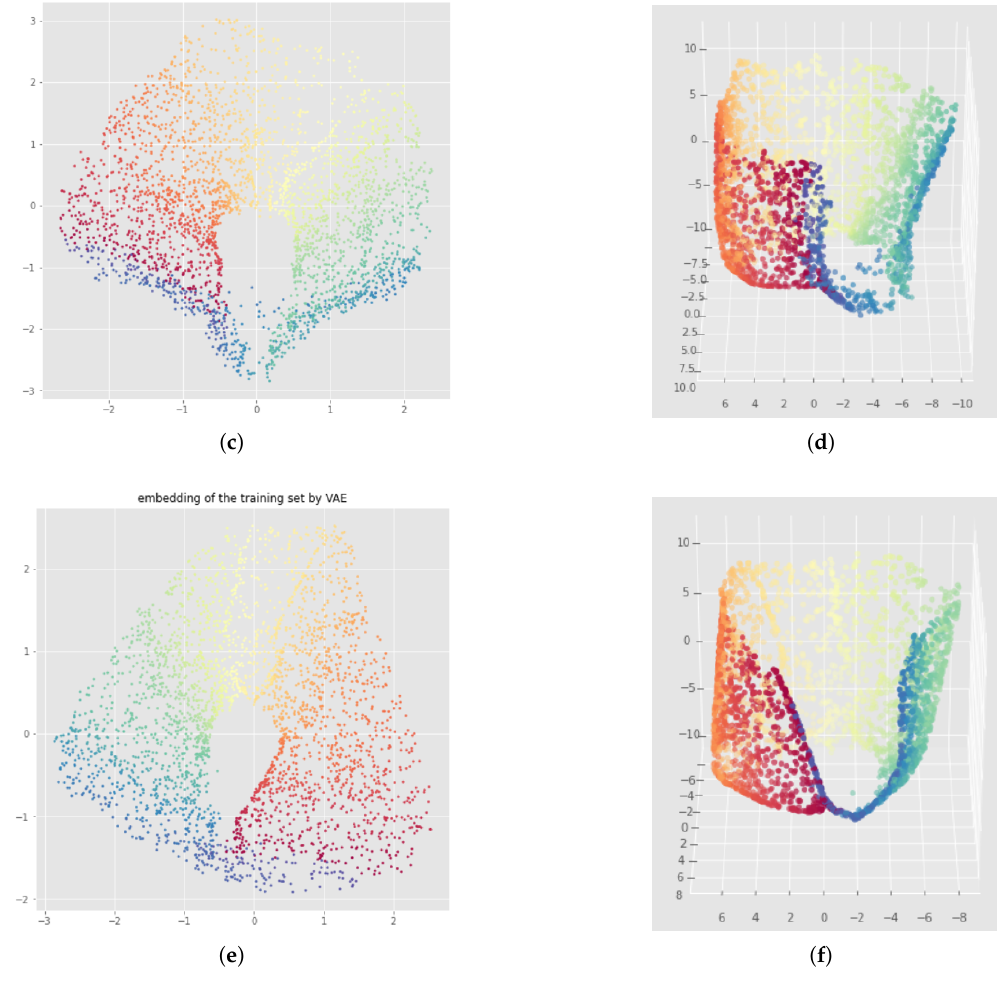
Figure 19. Witness Simplicial VAE applied to the open cylinder after 100 epochs, each row is a different neural network initialization: latent representations of the training set on the left and corresponding reconstruction on the right. Hyper parameters: batch size = 128, 10 landmarks, r filtration = 6, weights w SE = w SD = 10. ( a ) Latent representation. ( b ) Reconstruction. ( c ) Latent representation. ( d ) Reconstruction. ( e ) Latent representation. ( f ) Reconstruction.